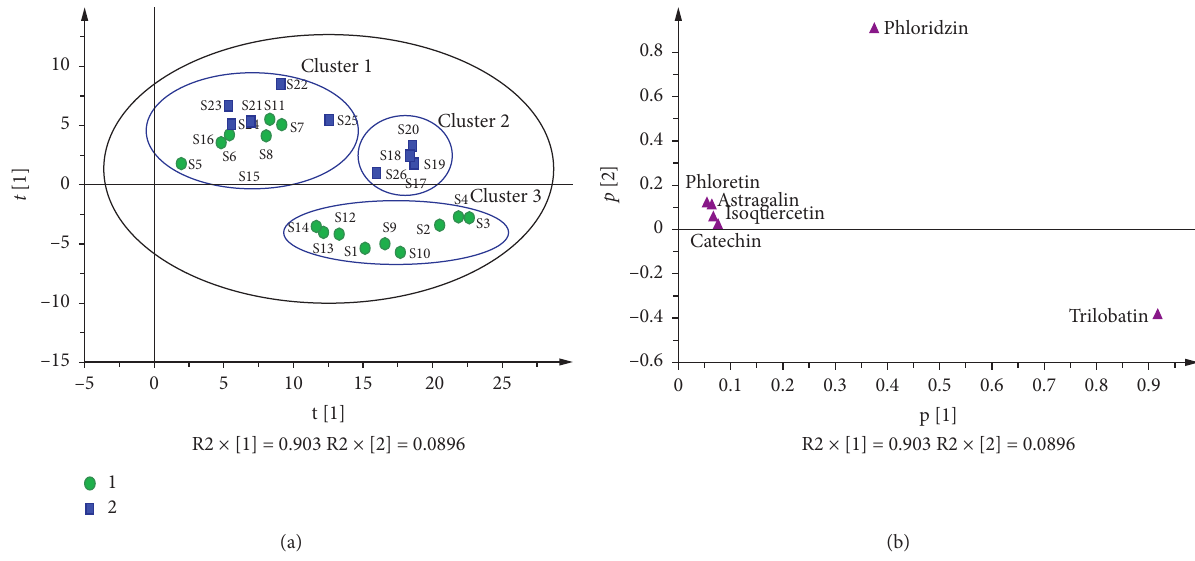
Figure 5: PCA analysis of the contents of six chemicals of LP samples. (a) PCA score plot shows distribution of samples into three clusters, series ((1) tender leaf; (2) flower spike). (b) Loading plot shows distribution of variables.